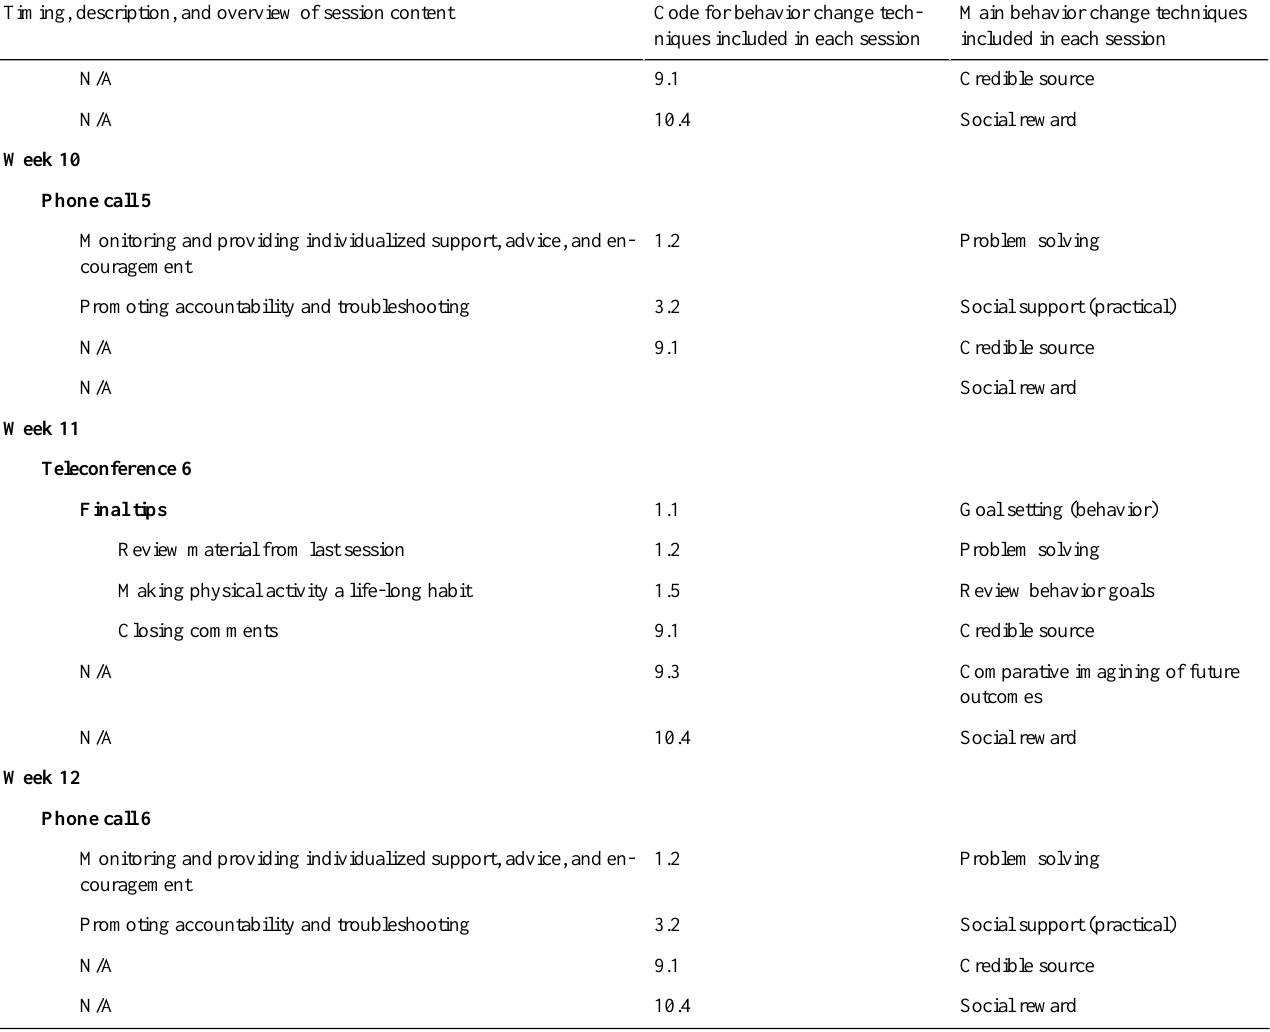
Table 2 provides a summary of the treatment outcomes and psychometric properties of the outcome measures included in the